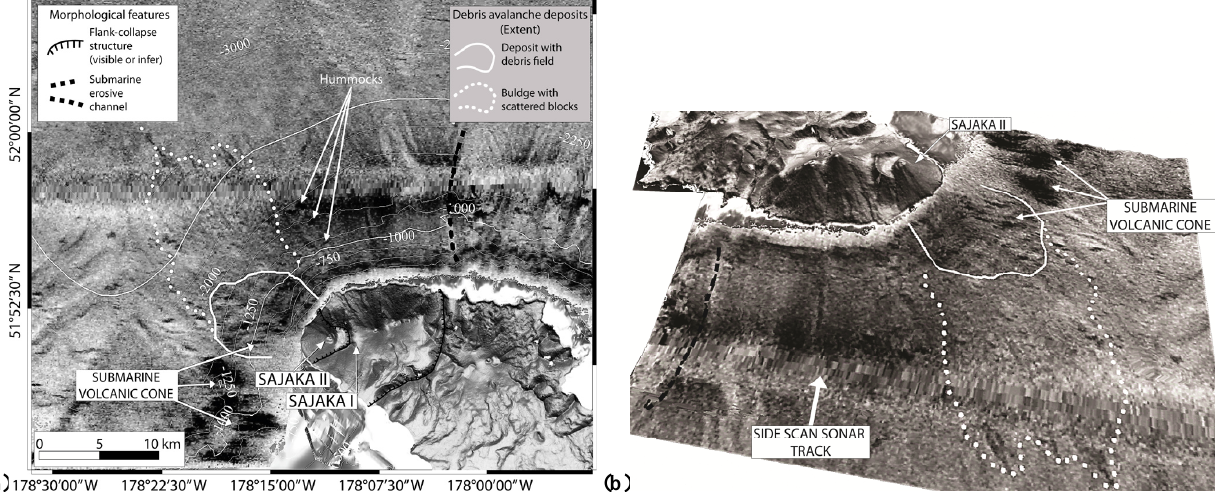
Fig. 7. (a) Plan view: topography, bathymetry and Gloria side-scan data of northern Tanaga cluster islands. (b) 3-D view: is reported a detailed view of the Sajaka II DA deposits. For side scan data the black is low backscatter and white is high backscatter. Contour interval is